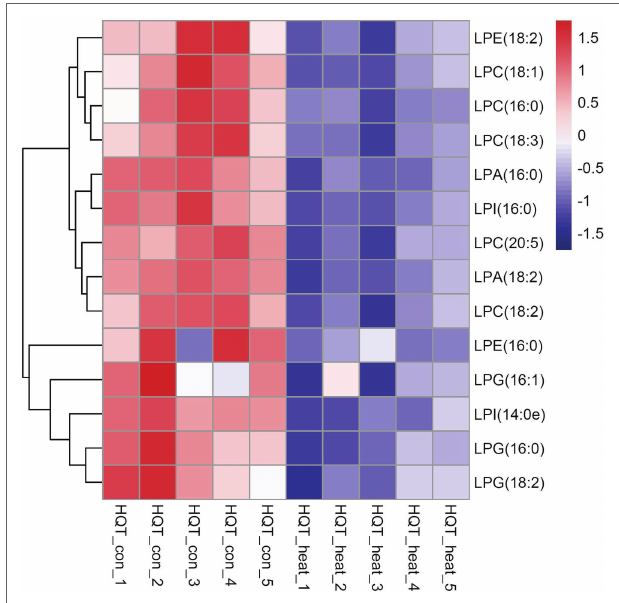
FIGURE 7 | Heat map of the significantly differential lysophospholipids in leaves of B. grandis in response to heat stress. Fully extended leaves detached from 173-d-old plants of B. grandis were at control condition (22 ° C for 2 h) or challenged with heat stress (45 ° C for 2 h). Each column represents an LC–MS measurement from five biological replicates of control condition (HQT_con_1 to HQT_con_5) or five biological replicates of heat treatment (HQT_heat_1 to HQT_heat_5). The lysophospholipid species of lysophosphatidic acid (LPA), lysophosphatidylcholine (LPC), lysophosphatidylethanolamine (LPE), lysophosphatidylglycerol (LPG), and phosphatidylinositol (LPI) measured from the control and heat treatment conditions were shown.